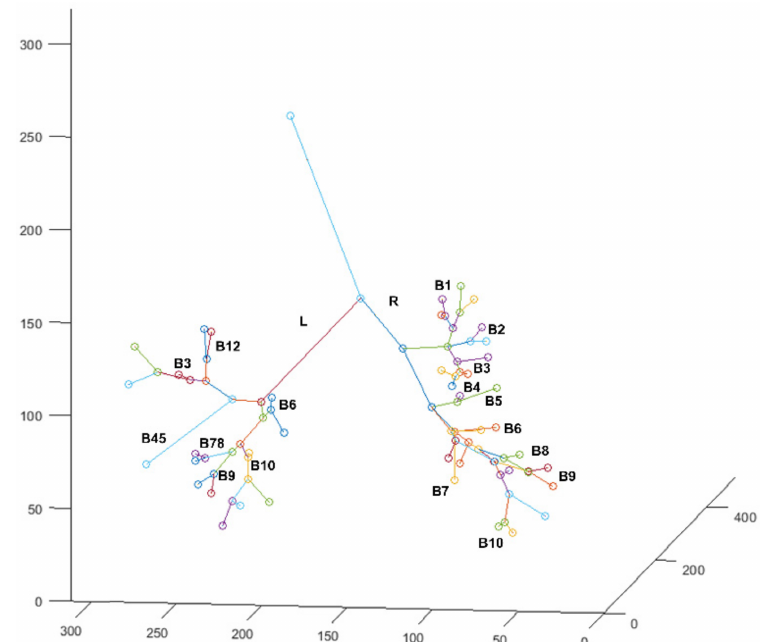
Figure 10. Labeled tree structure.